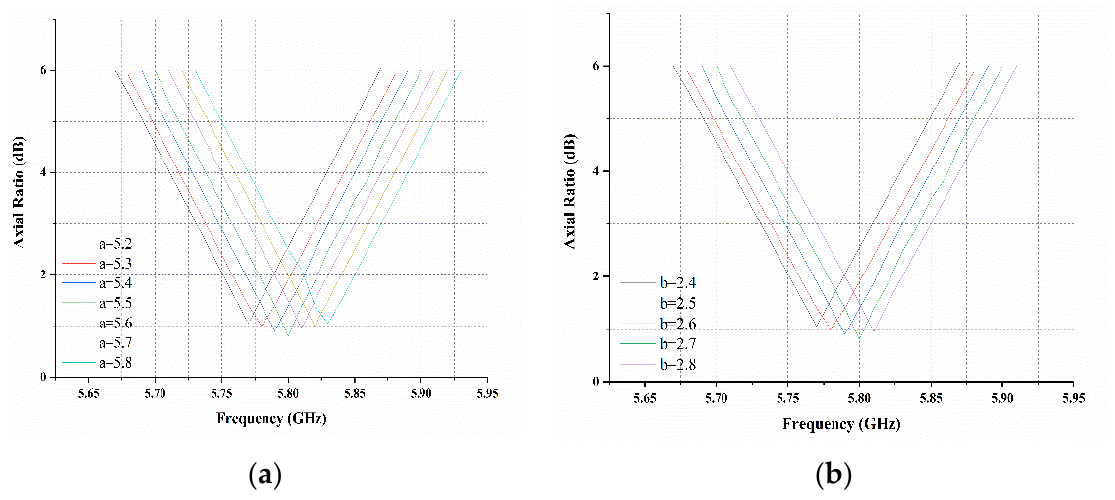
Figure 9. The AR variation corresponding to elliptical slot radii alteration: ( a ) Radius a ; ( b ) Radius b .